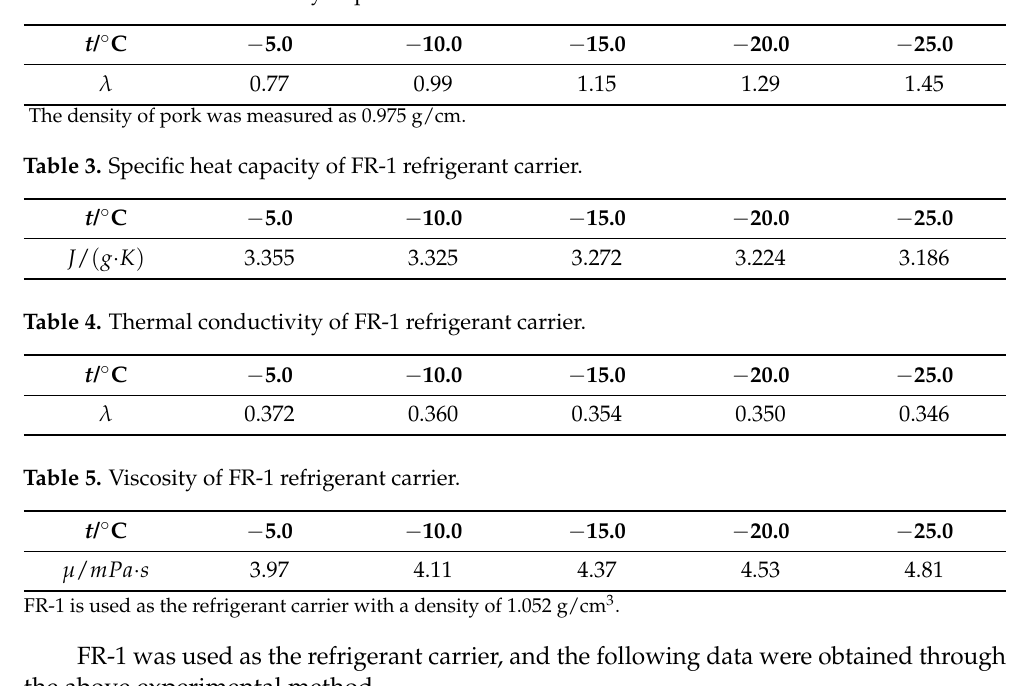
Table 2. Thermal conductivity of pork.